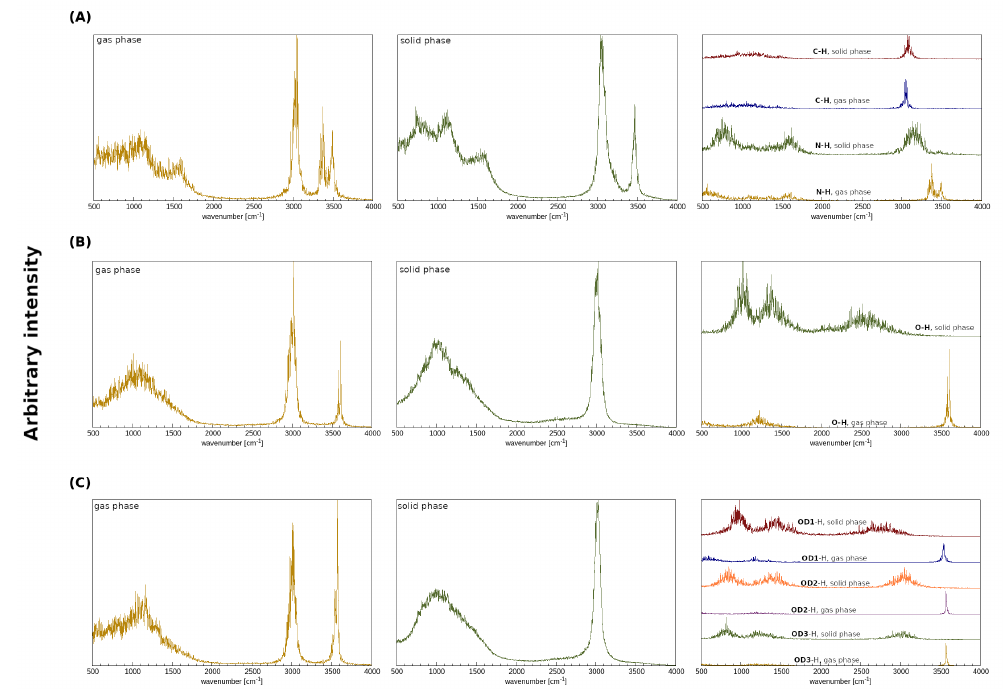
Figure 3. Atomic velocity power spectra obtained from the CPMD simulations. Left panel: the whole atomic spectra in the gas phase. Middle panel: the whole atomic spectra in the crystalline phase. Right panel: the contribution of the bridged protons in the crystalline and in the gaseous